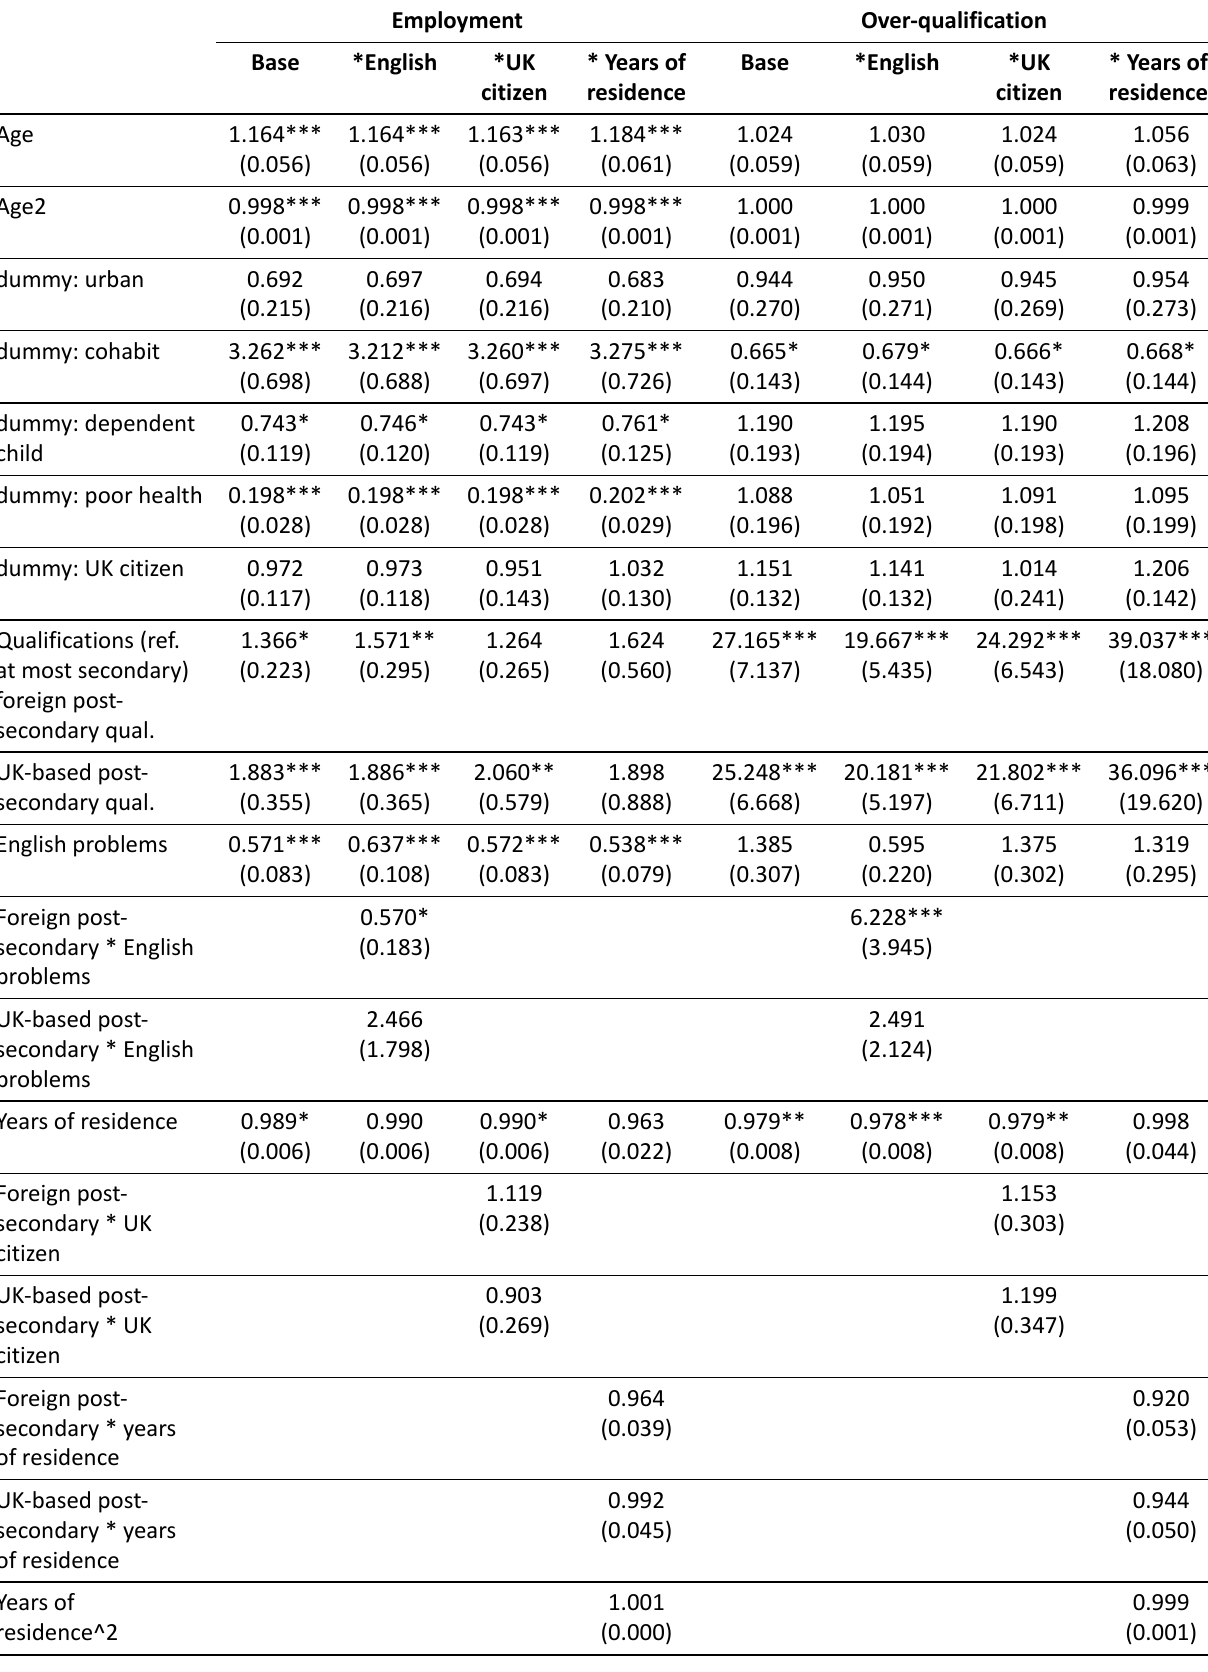
Table A5. Binary logistic regression model with sequential interactions of post-secondary qualifications for